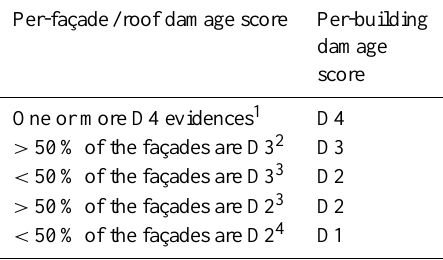
Table 4. Description of the algorithm created to aggregate the per- façade/roof damage score at the building level.